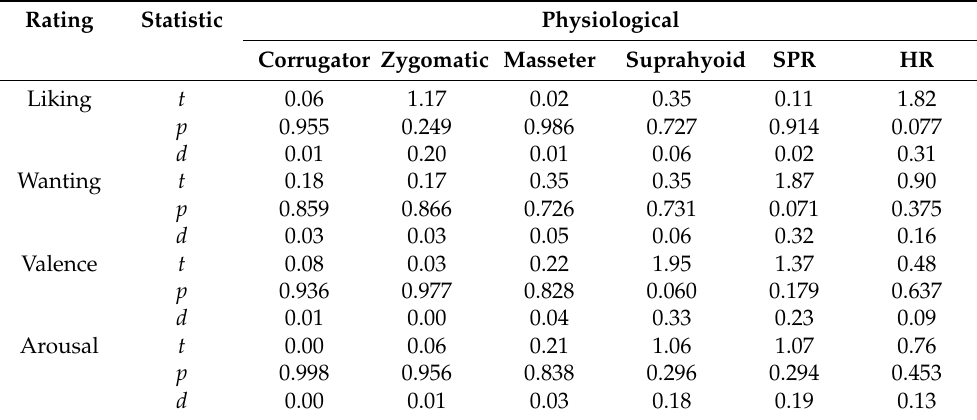
Table 3. Results of one-sample t -tests (two-tailed; t -, p -, and Cohen’s d -values) for correlation coefficients between nutritional information and physiological signals.